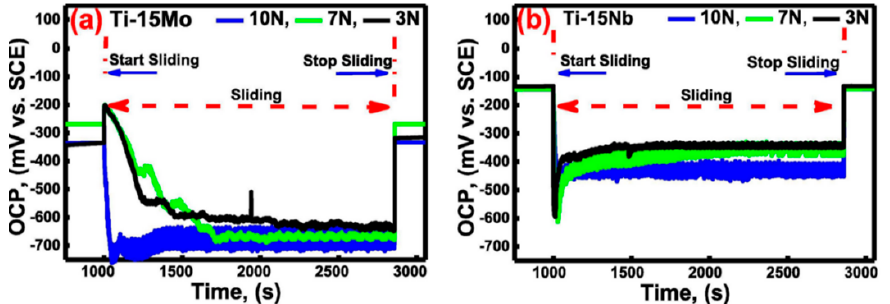
Figure 2. The OCP evolution during tribocorrosion under varying load: ( a ) Ti-15Mo, ( b ) Ti-15Nb. (Reprinted from Materials Letters, 257, M. Fellah, N. Hezil, M. A. Hussein, M. A. Samad, M. Z. Touhami, A. Montagne, A. Iost, A. Obrosov, and S. Weiss, Preliminary investigation on the bio-tribocorrosion behavior of porous nanostructured β -type titanium based biomedical alloys, 126755, Copyright (2019), with permission from Elsevier.)